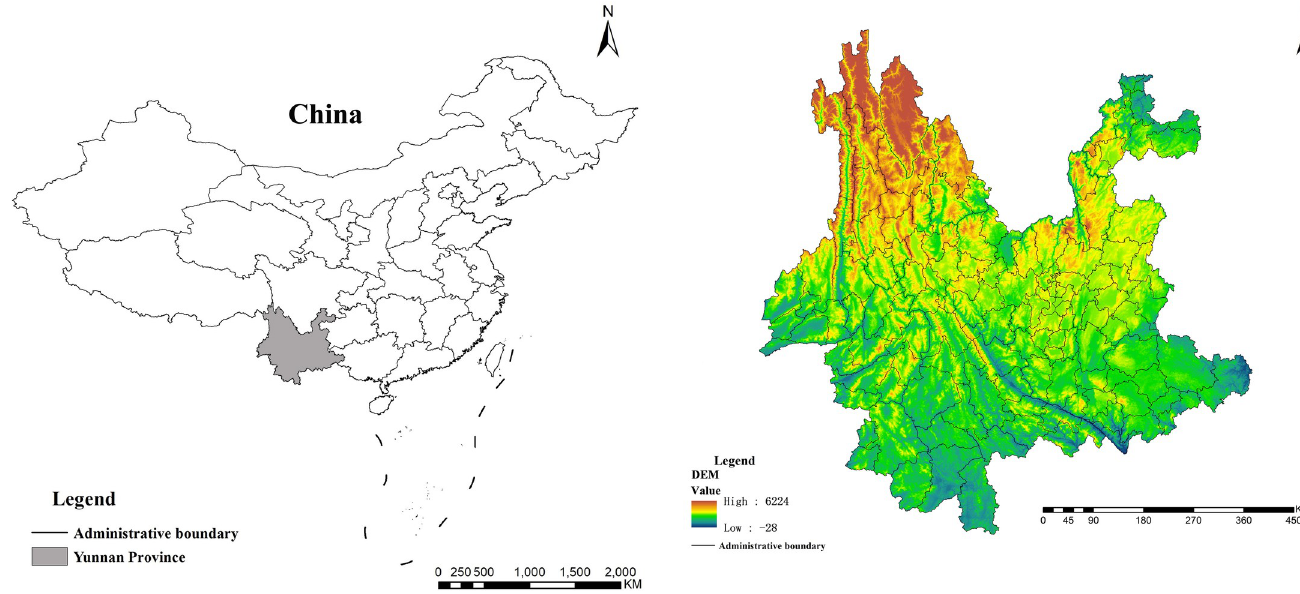
Fig 1. Location of Yunnan Province. (Data source: http://bzdt.ch.mnr.gov.cn/index.html).